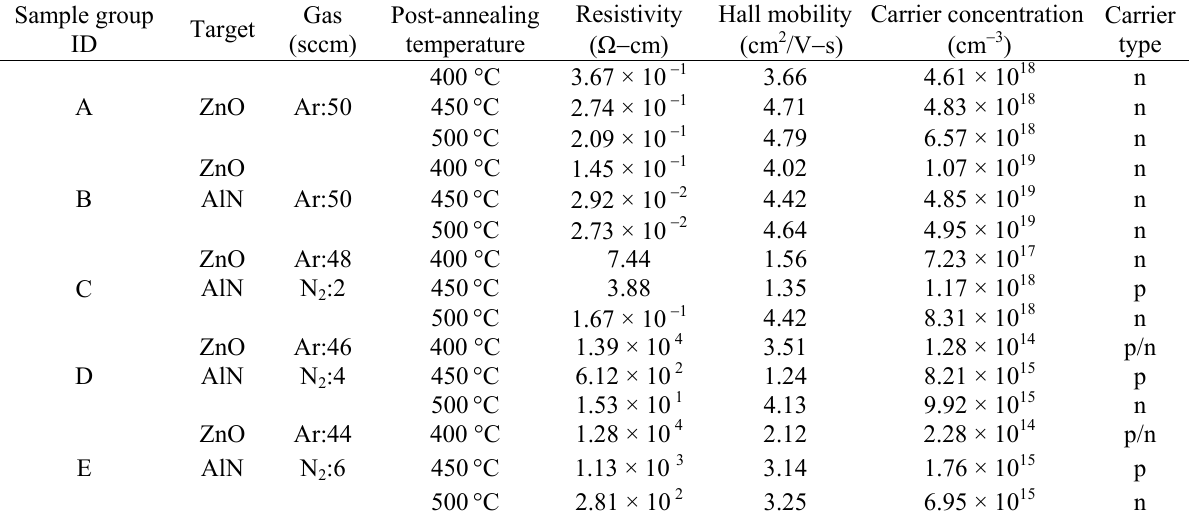
Table 4. Resistivity, Hall mobility, carrier concentration, and carrier type measured by Hall measurement for films deposited at various conditions. Reprinted from Ref. [20] with